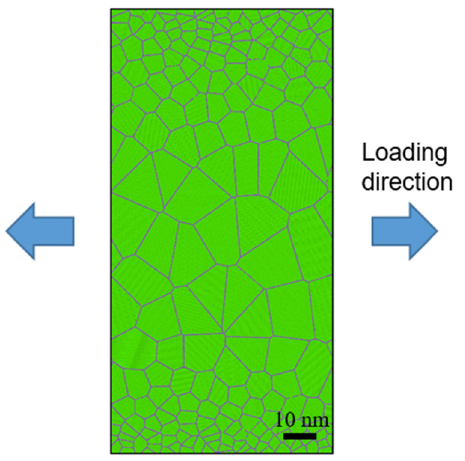
Figure 1: Topological con fi guration of GNG copper with gradient 3 –